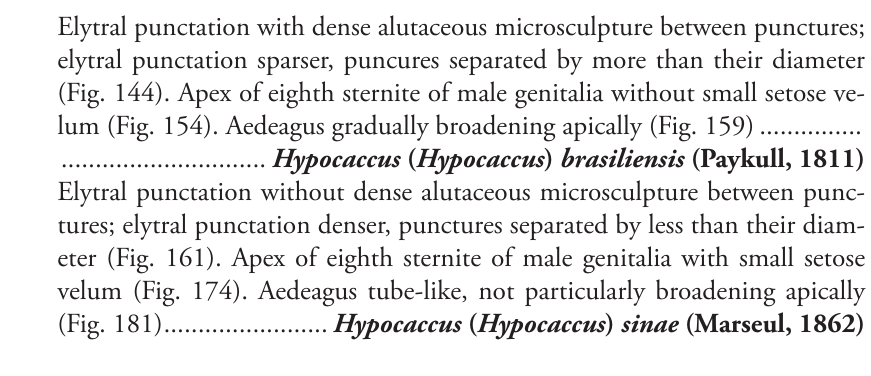
Elytral punctation with dense alutaceous microsculpture between punctures; elytral punctation sparser, puncures separated by more than their diameter (Fig. 144). Apex of eighth sternite of male genitalia without small setose ve- lum (Fig. 154). Aedeagus gradually broadening apically (Fig. 159)